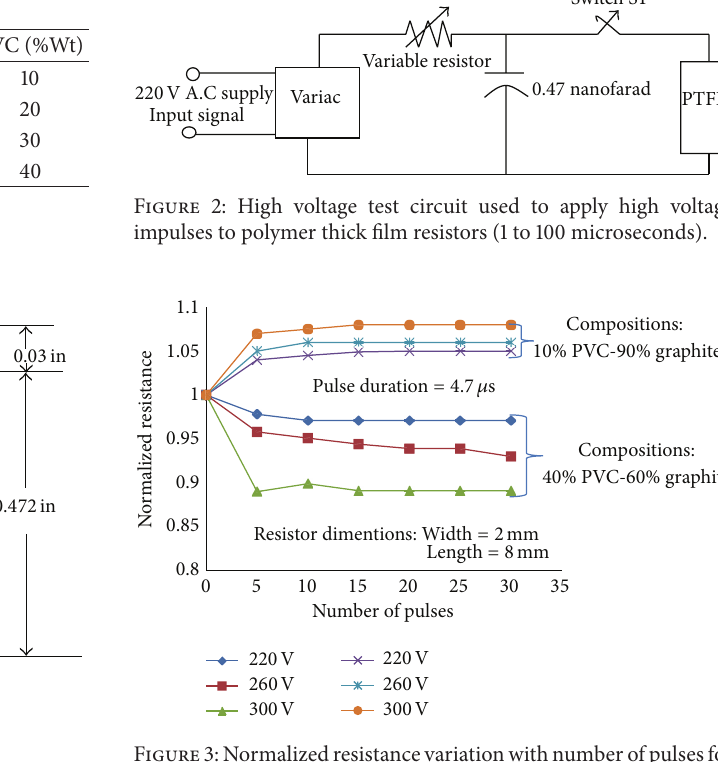
Figure 1: Structure of a typical polymer thick film resistor. Table 2: Details of the thick film resistors fabricated. S. number